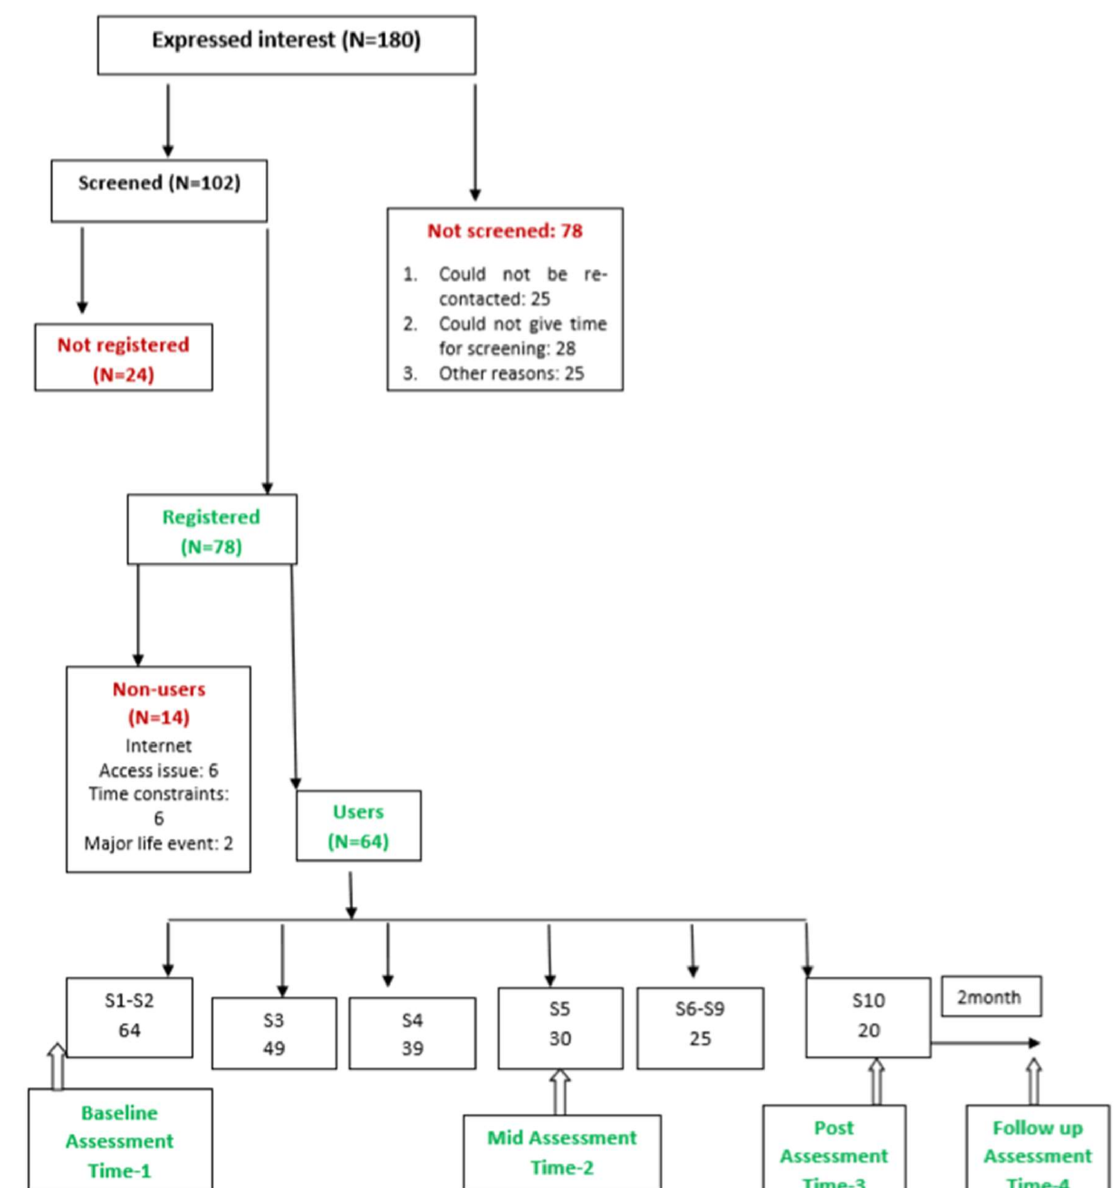
Figure 1. Flow Chart of pilot trial. Note: S1-S10 refer to the 10 sections in the essential zone of PUSH-D & the figures below section numbers refer to number of users who used the respective